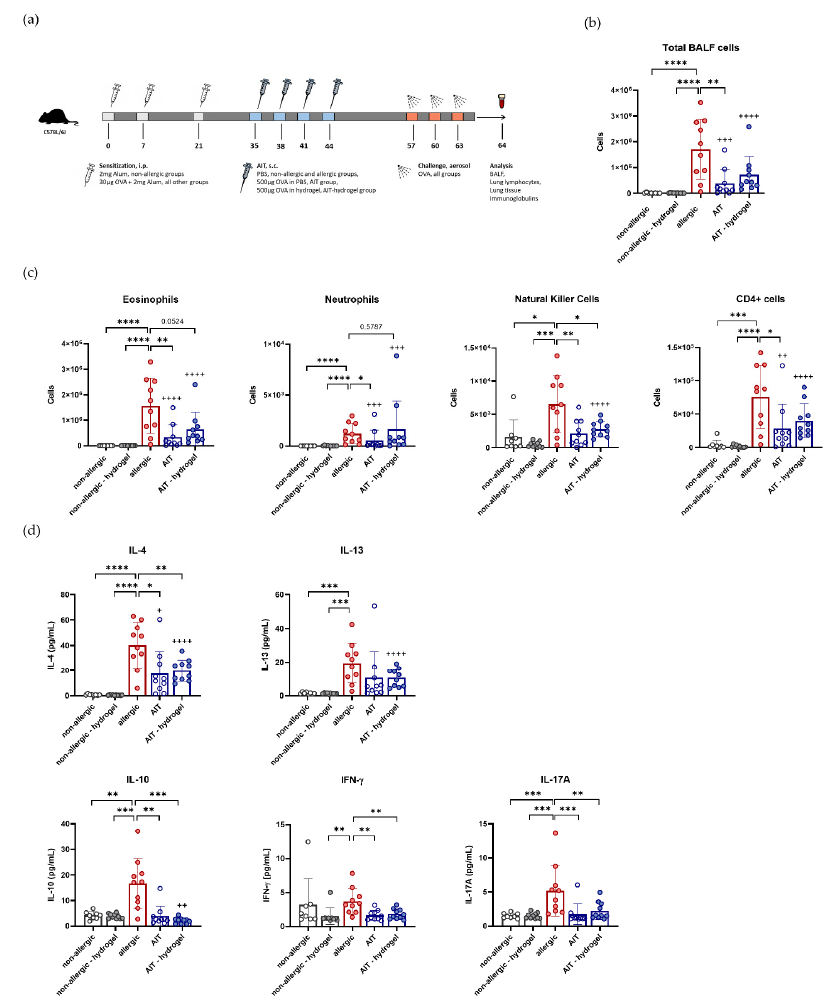
Figure 3. Effects of AIT delivered with hydrogel in comparison to standard AIT treatment on BALF cells and cytokines. ( a ) Schematic overview of AIT in a murine model of allergic asthma. ( b ) Total BALF cell count ( n = 10). ( c ) Differential cell counts of eosinophils, neutrophils, natural killer cells, and CD4+ cells in the BALF ( n = 10). ( d ) Levels of IL-4, IL-13, IFN- γ , IL-10, and IL-17A analyzed in the BALF ( n = 10). Gaussian and non-Gaussian distributed results were analyzed by unpaired t-test or Mann–Whitney test, respectively. p -values of ≤ 0.05, ≤ 0.01, ≤ 0.001, and ≤ 0.0001 are shown as *, **, ***, and ****, respectively. p -values of AIT groups compared to the respective non-allergic groups are shown as +, ++, +++, and ++++, respectively.